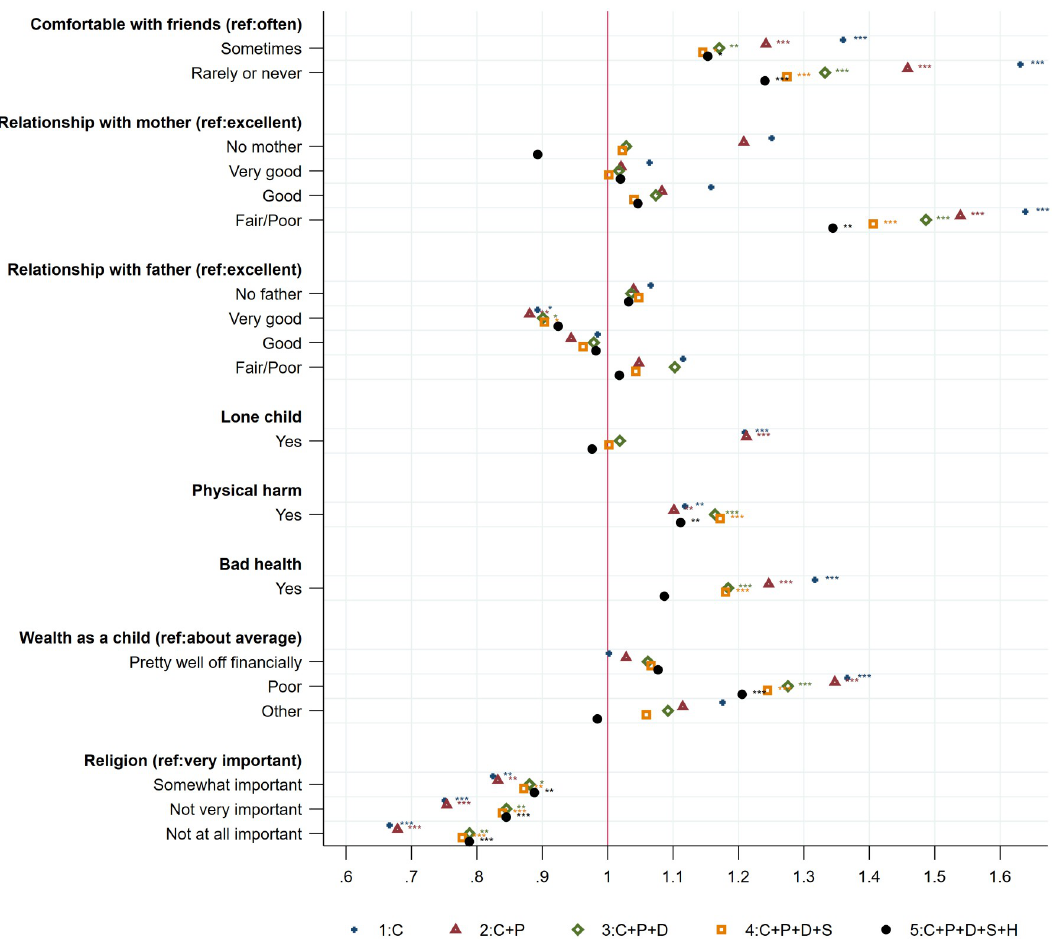
Fig 1. Loneliness at 50+: The role of childhood circumstances. Note: The figure displays odds ratios of the variables describing childhood circumstances for the five different specifications. Specification (1) includes C, a vector of childhood circumstances (wealth; health; quality of the relationship with mother, father, and friends; importance of religion), and I, country-specific fixed effects. Specification (2) includes (1) and P, a vector of the five scores of personality traits (extraversion, agreeableness, conscientiousness, neuroticism, and openness). Specification (3) includes (2) and D, a set of individual socioeconomic and demographic variables at age 50+. Specification (4) includes (3) and S, social support, activities, and network variables at age 50+. Specification (5) includes (4) and H, a vector of individual health information at age 50+. Reading example: in the full specification, reporting having had rarely or never friends with whom spending comfortable time in childhood increases the risk of feeling lonely at age 50+ by 1.24. The pseudo R 2 and the proportion of correctly specified outcomes are respectively for each specification: (1): 0.0364; 82.89%, (2): 0.0600; 82.99%, (3): 0.0864; 82.96%; (4): 0.1181; 83.39%, (5): 0.1699; 84.09%. � p < 0.05, �� p < 0.01, ��� p < 0.001.